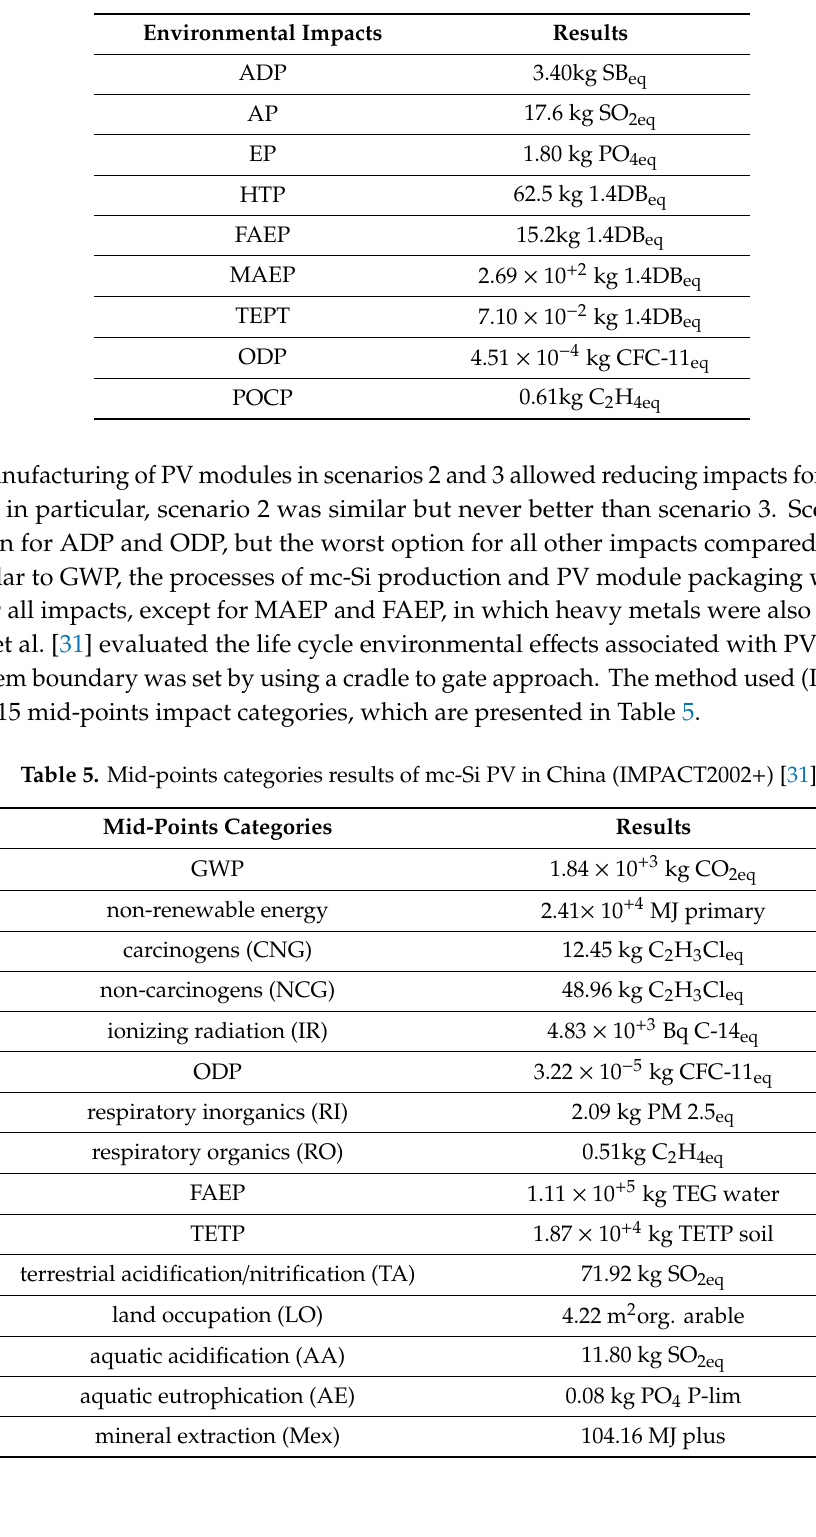
Table 4. Environmental impacts of mc-Si PV in scenario 1 [30].